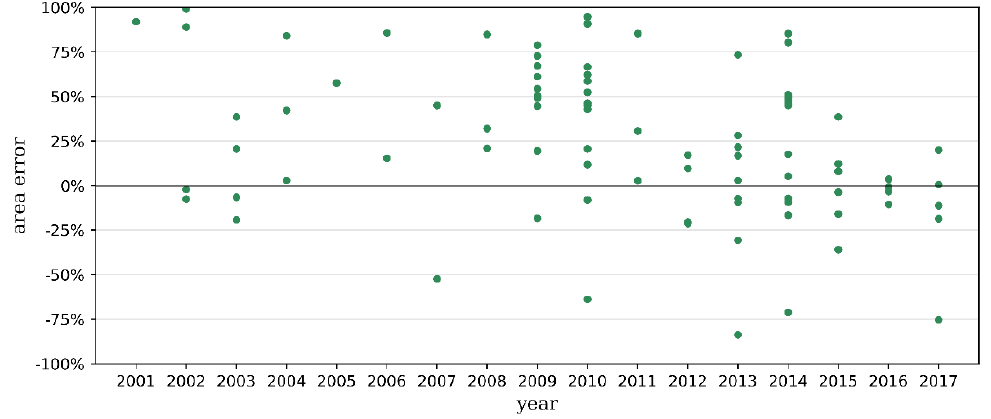
Figure 11. Development of the FCLE area error over time.